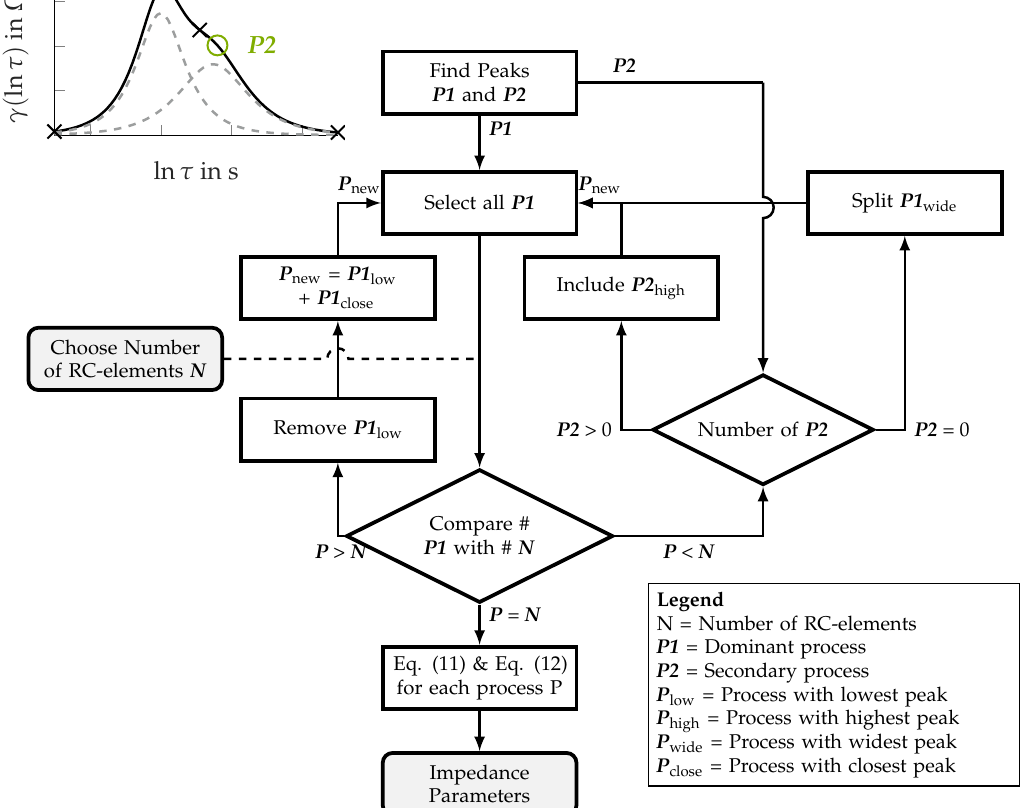
Figure 4. Flow chart of the proposed DRT-fitting for automated parameterization of RC elements from the DRT. Initially, all local maxima in the DRT are identified and labeled P 1, while all